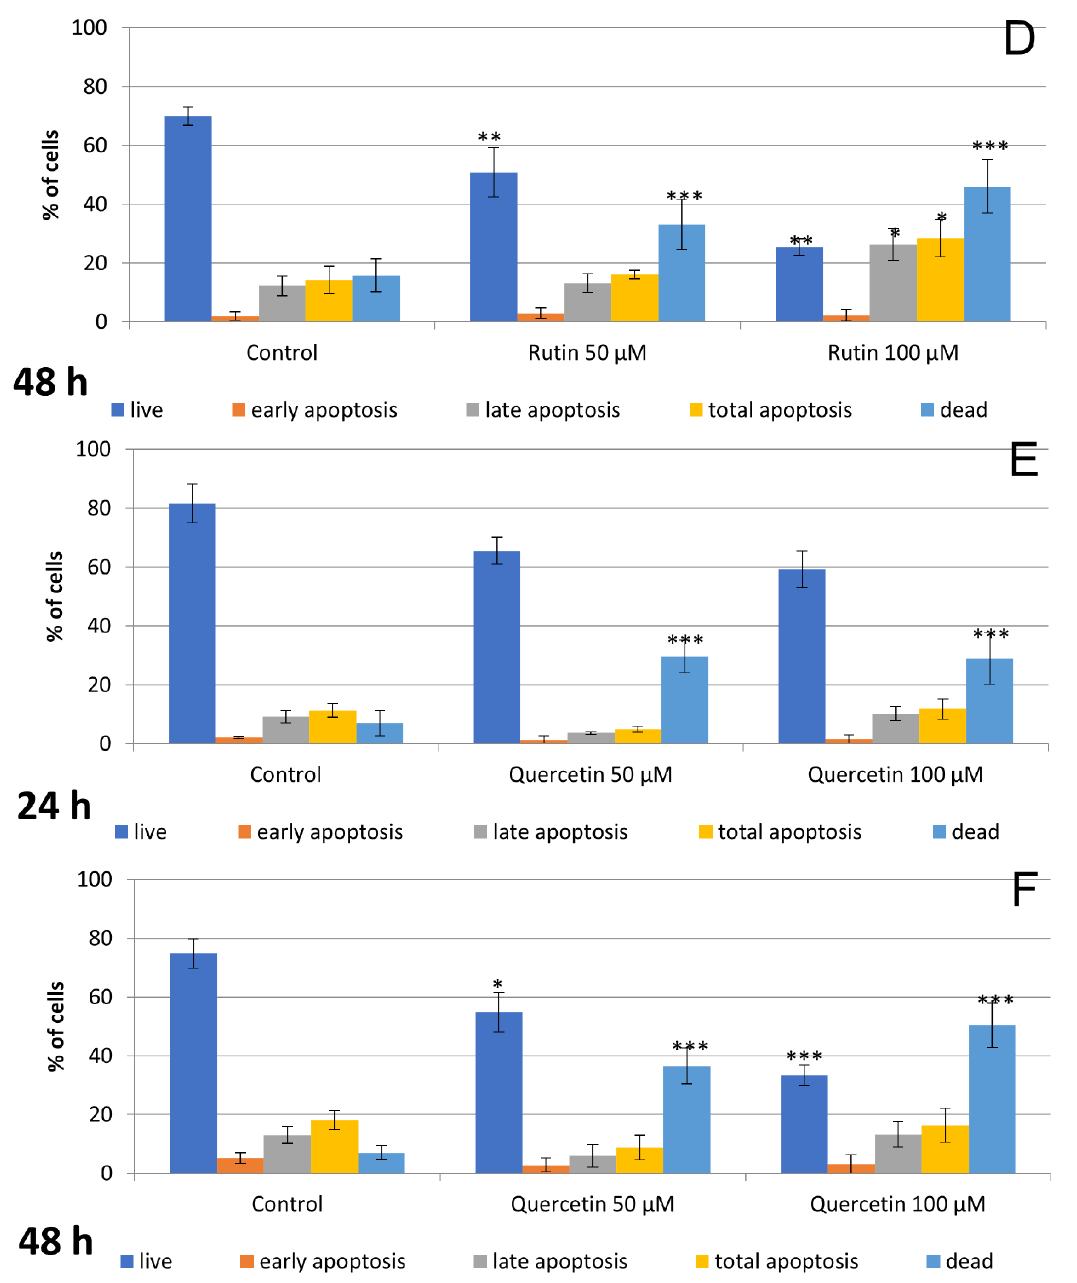
Figure 2. Flow cytometric analysis results. A significant increase in the proportion of total dead Detroit 562 cells following 48 h ( B , D , F ) vs. 24 h ( A , C , E ) of exposure to Hes, Rut, Que of 50 and 100 µ M concentration, compared to the control (* p < 0.05, ** p < 0.01 and *** p < 0.001). Vertical bars represent the standard deviations of the means (SD, n = 3 experiments).